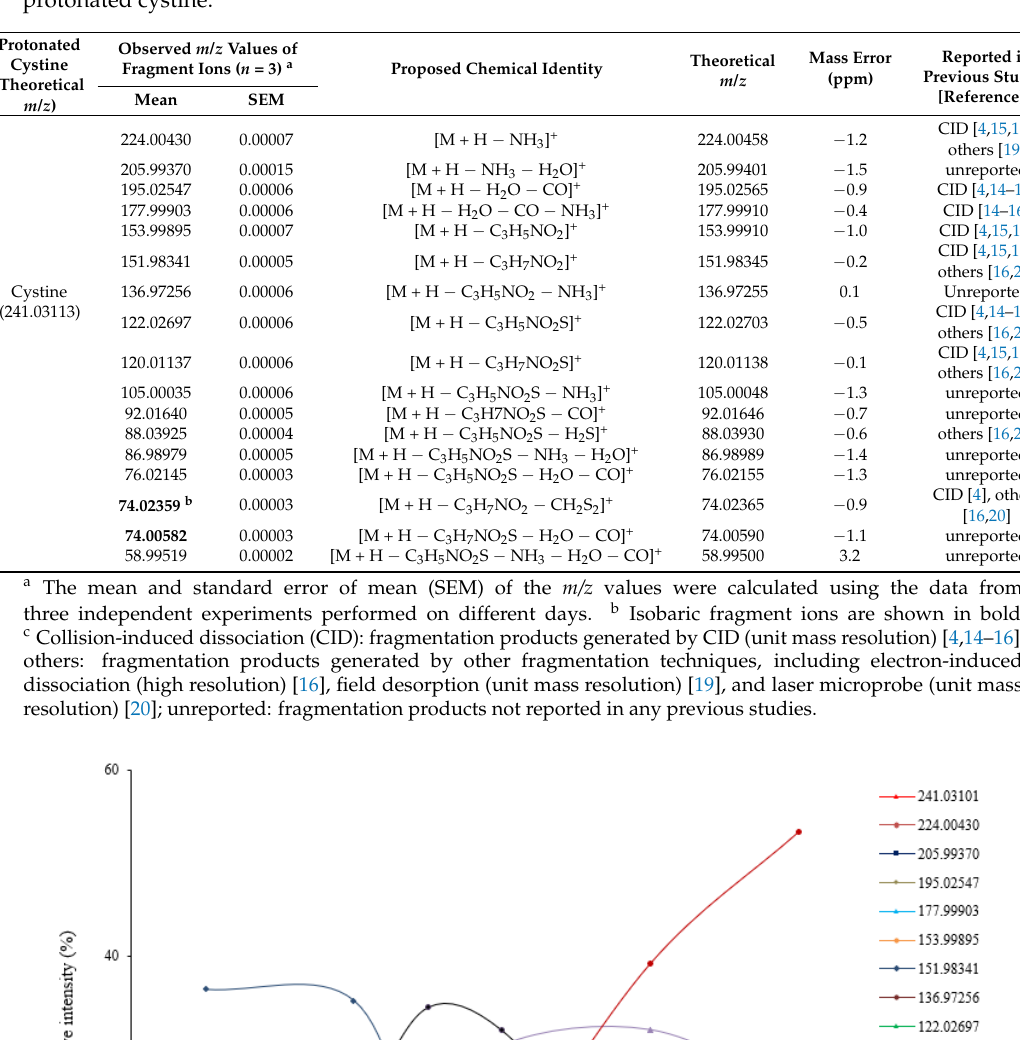
Table 1. Summary of m/z values and assigned chemical identities of fragmentation products of protonated cystine.